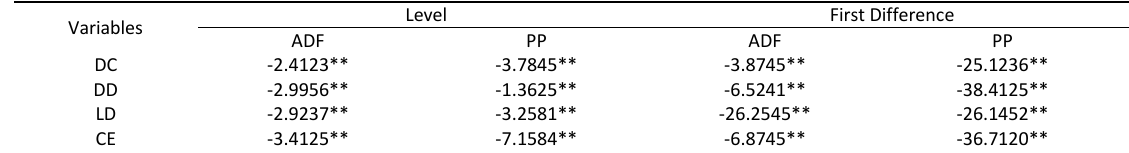
Table 1: Unit root test results